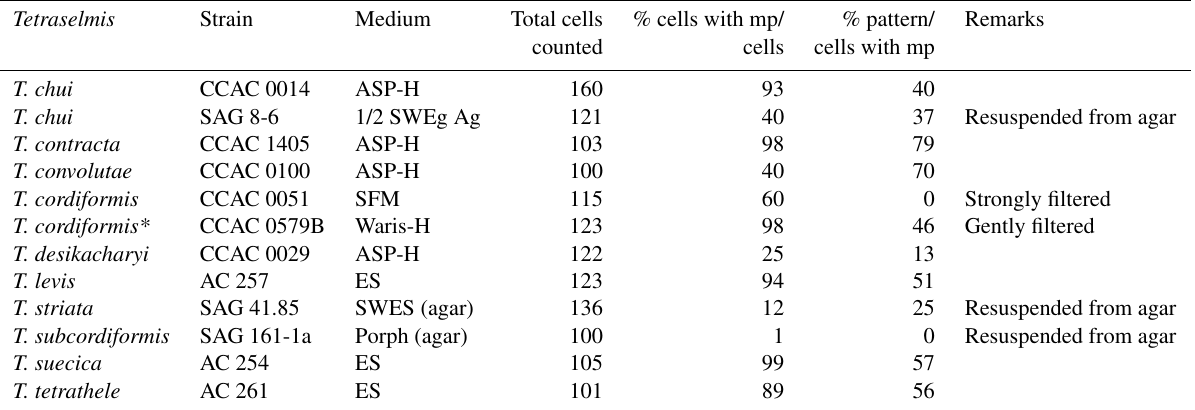
Table 2. Percentage of cells presenting micropearls and specific patterns of micropearl arrangement. Percentage of cells presenting micro- pearls for each strain and percentage of these cells showing the typical micropearl arrangement pattern for that species (see Figs. 1 and S1). Two strains have been analyzed for T. chui and T. cordiformis . Please note that strains grown on agar generally show a much lower presence of micropearls and were not considered for the statistics. The asterisk marks a single sample taken 60 days after the strain’s arrival in our laboratory, while all the others were observed on the first day after arrival from the provider. This exception allowed us to estimate the number of cells showing the micropearl arrangement pattern of this species, as both samples of T. cordiformis strains taken on the first day were damaged during sample preparation by too strong of a filtration. On the first day after arrival, strain CCAC 0579B gave results similar to those of strain CCAC 0051. mp: micropearls. For details on providers and media, see Table 1. Tetraselmis Strain Medium Total cells % cells with mp/ % pattern/ counted